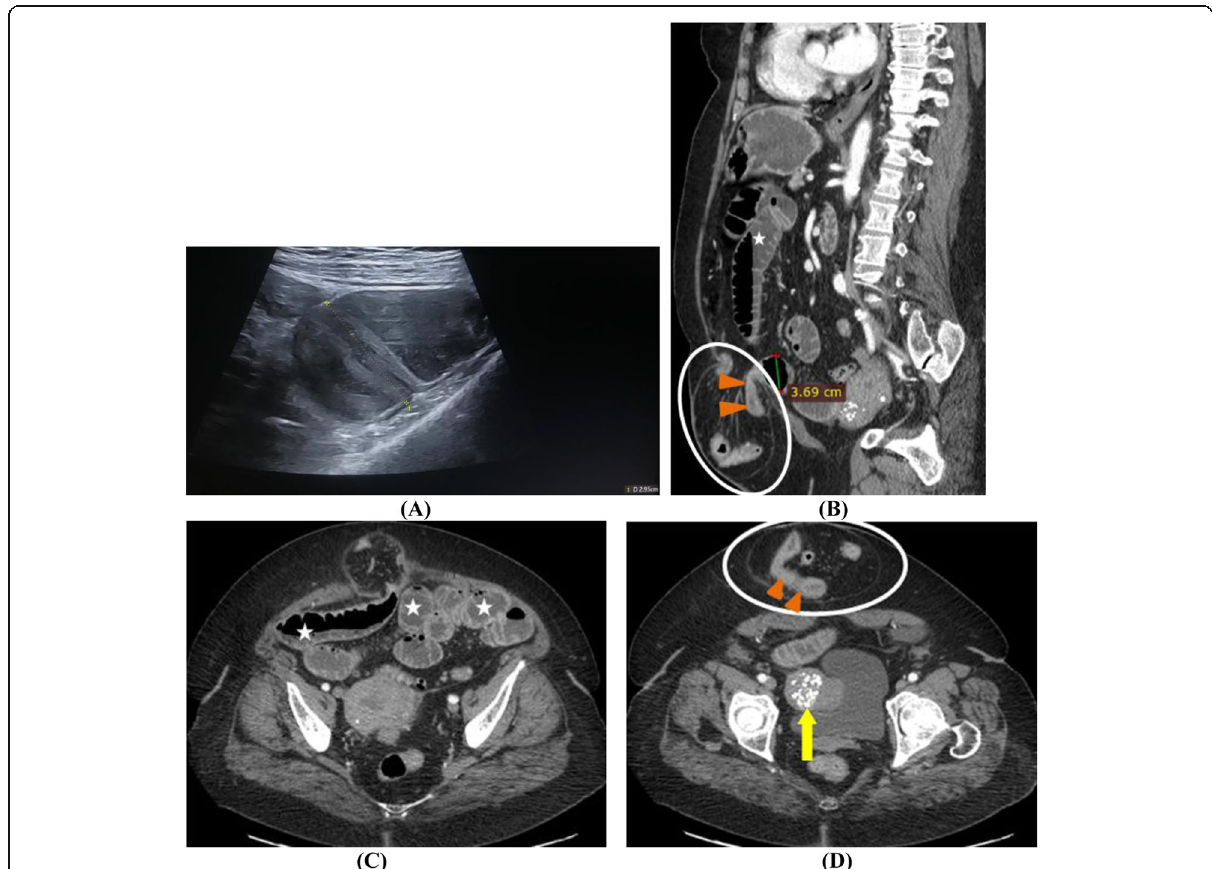
Fig. 7 High-grade mechanical small bowel obstruction caused by paraumbilical hernia in a 78-year-old female patient complaining of acute abdominal pain. a Abdominal ultrasound image showing dilated small bowel loops. CT sagittal image ( b ) and CT axial images ( c , d ), showing an hernial sac (circle) containing collapsed mid-ileal bowel loops (arrowheads) with consequent dilatation of the ileal and jejunal bowel loops proximal to herniated loop (stars). A calcified uterine fibroid (yellow arrow) is incidentally seen on ( d ) axial CT